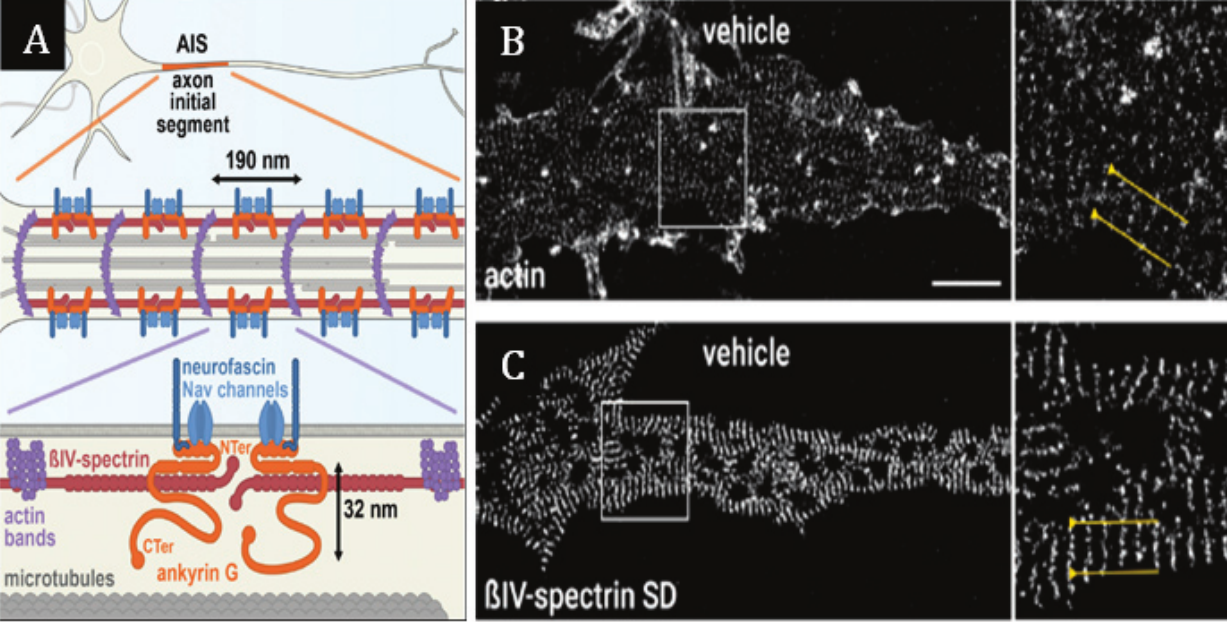
Figure 5. Schematic graphical representation of the axon initial segment constructed from stochastic optical reconstruction microscopy (STORM) imaging data of β IV spectrin, ankyrin G, actin, and microtubules. ( a ) The schematic shows that head-to-head β IV-spectrins connect the actin rings to form a periodic sub-membrane complex while ankyrin G C-terminal tails extend 32 nm below the sub- membrane complex to allow possible interactions with the microtubule cytoskeleton that are important for establishing and maintaining axonal identity. ( b , c ) STORM images of neurons treated with vehicle (dimethyl sulfoxide 0.1%; 1 hour; b , c ) and then fixed and labeled for actin ( b ) or β IV-spectrin specific domain (SD) ( c ). Scale bar = 2 μm. Taken and modified from